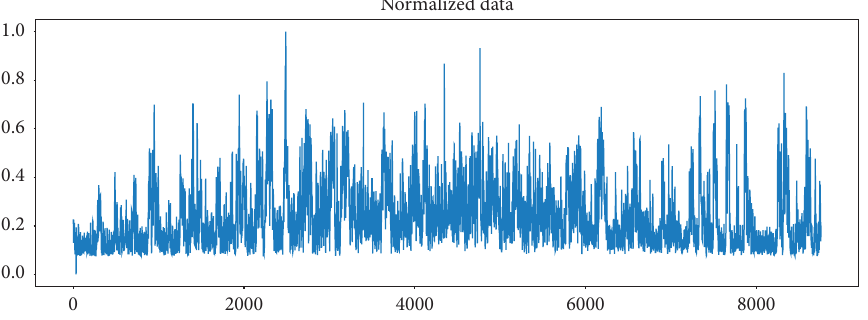
Figure 5: Wind speed data after null filling.